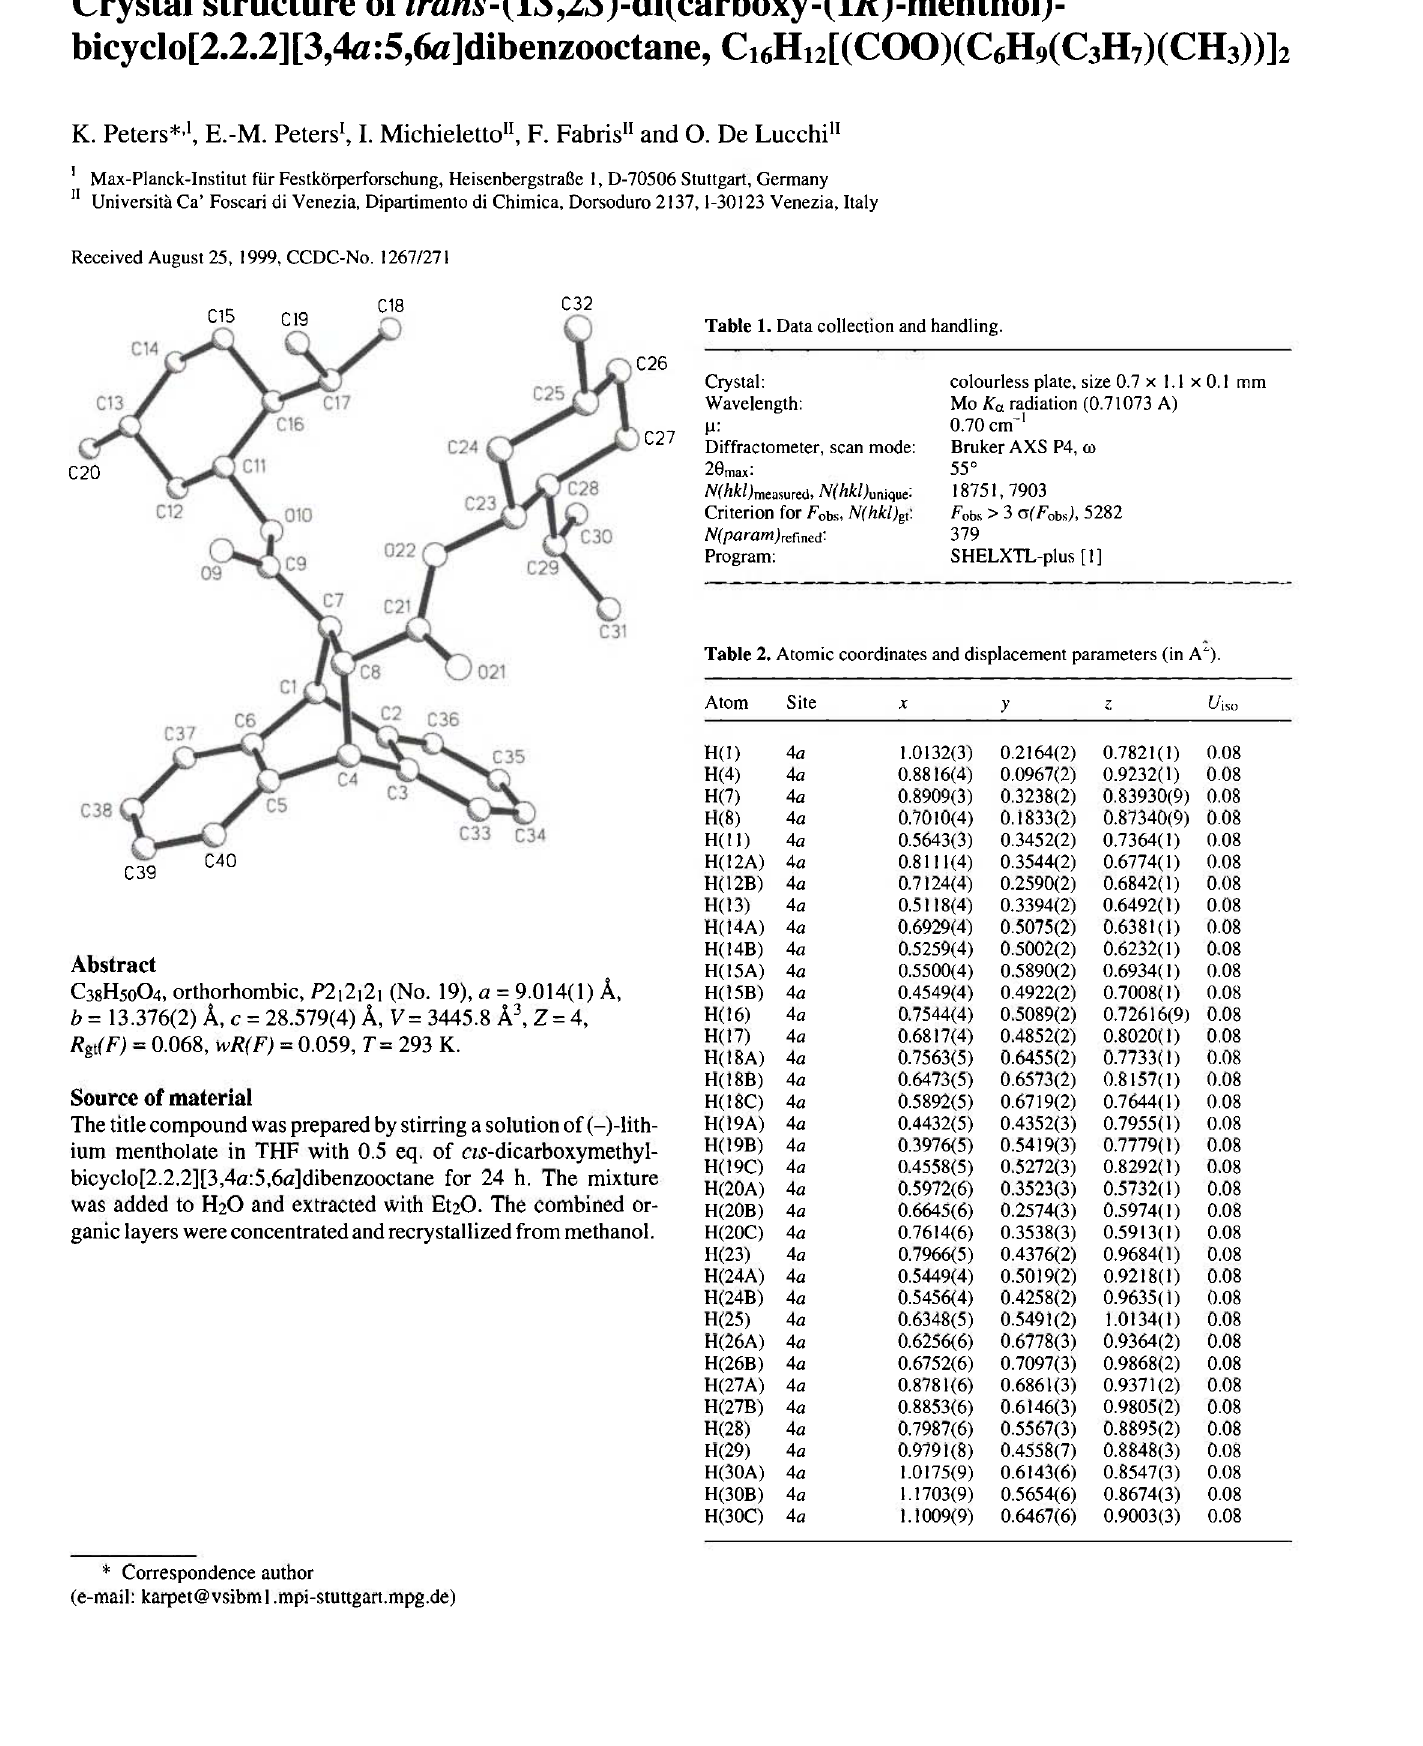
Table 1. Data collection and handling.